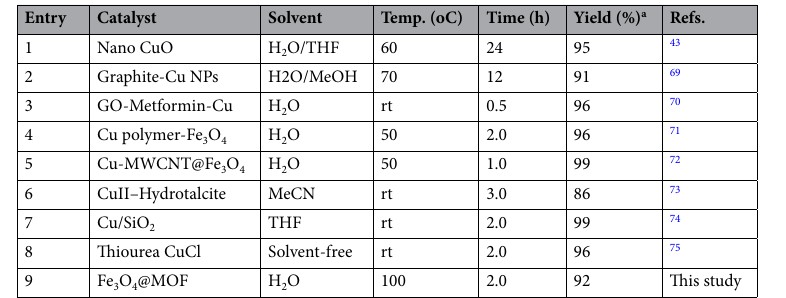
Solvent Temp. (oC) Time (h) Yield (%) a